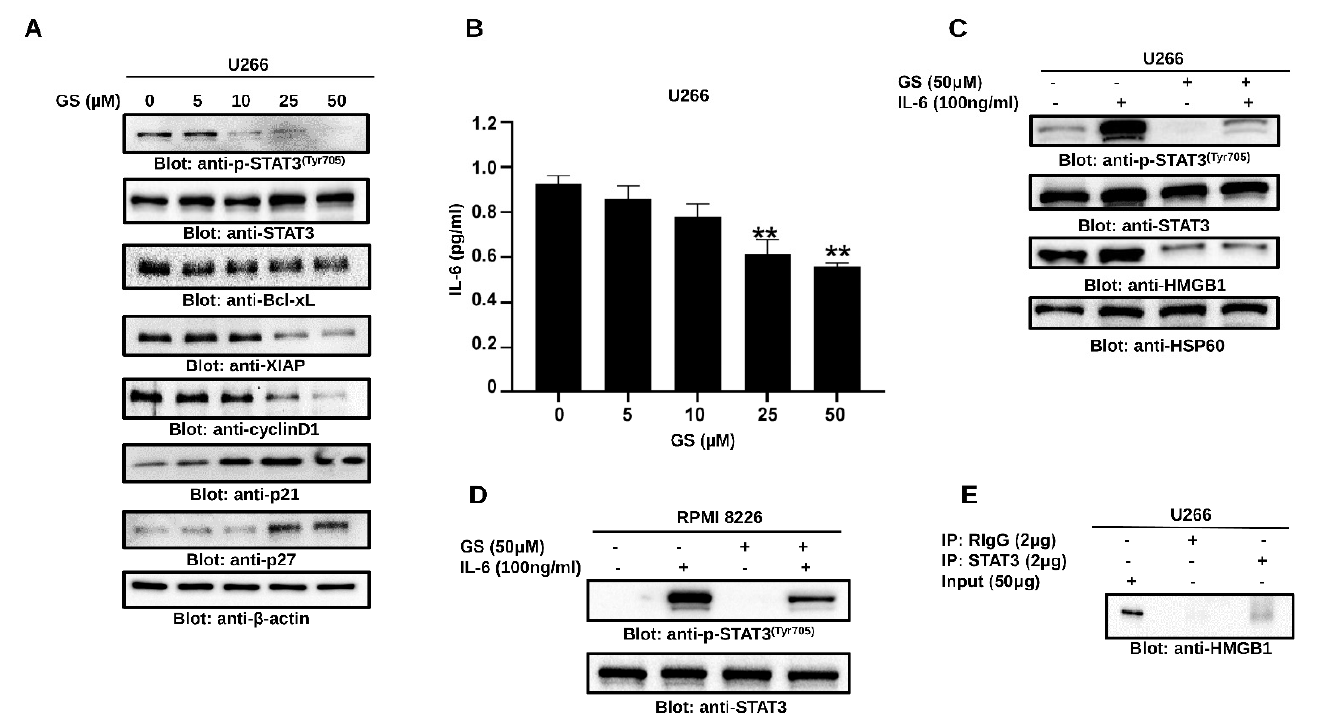
Figure 6. GS downregulates the constitutive and inducible STAT3 signaling. U266 cells were incu- bated with increasing concentrations of GS for 48 h, and ( A ) protein expressions of p-STAT3, STAT3, Bcl-xL, XIAP, Cyclin D1, p21 Cip1 p27 Kip1 , and β -actin were determined. ( B ) GS-mediated inhibition of IL-6 secretion. GS treated U266 cells supernatant was collected, and quantitative analysis for IL-6 was performed using a multiplexing kit. The graph displays mean ± SD (n = 3 and ** p < 0.001). IL-6-induced STAT3 activation in MM cells; 24 h serum-starved ( C ) U266 and ( D ) RPMI 8226 cells were pre-treated with 50 µ M GS for 48 h and then with IL-6 (100 ng/mL) for 30 min. Total proteins were extracted and probed against p-STAT3, STAT3, HMGB1, and HSP60. ( E ) Association of STAT3 and HMGB1. U266 cells were lysed and immunoprecipitated either with normal rabbit IgG (RIgG) or antibody against STAT3 using sepharose 4G. Immunoprecipitated proteins were analyzed by SDS-PAGE and immunoblotted with antibody against HMGB1. Full Western blot images can be found at Supplementary Materials File S1.